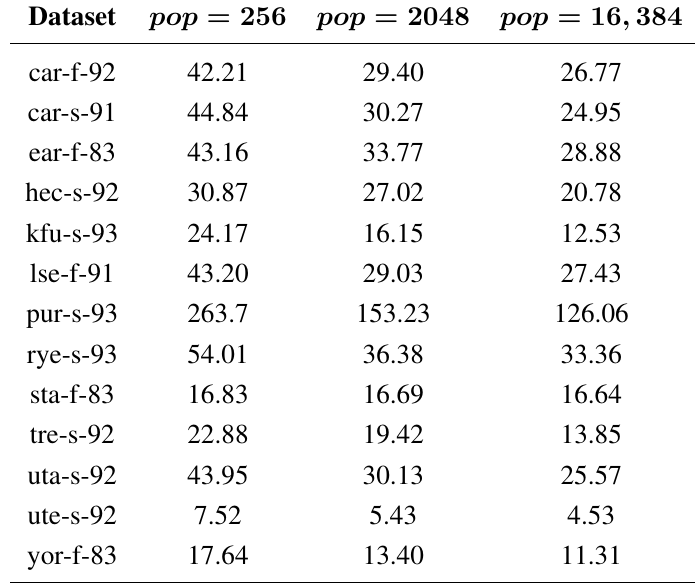
Table 5. Average distance (%) from the best reported solution in the bibliography with the hybrid evolutionary